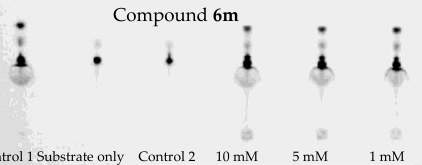
Figure 4. The bands of compounds 3 , 6p , 6q , and 6m interacted with MCR-1 protein for inhibiting the reaction of phosphoethanolamine (PEA) transfer by thin layer chromatography (TLC); Control 1: The bands of substrate interacted with MCR-1 protein; Control 2: The bands of tested compounds interacted with the